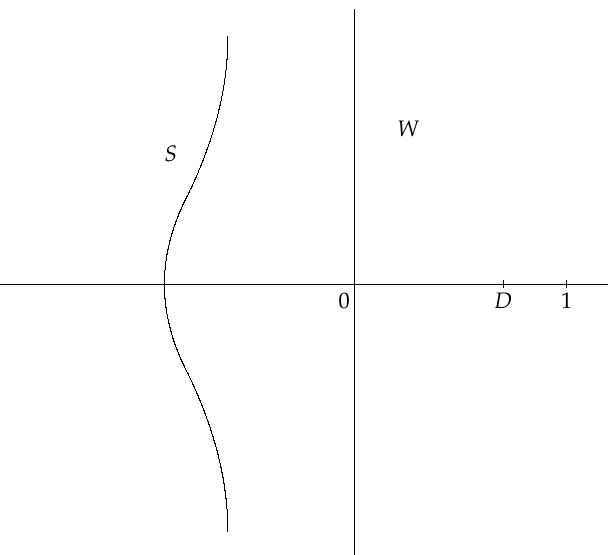
Figure 1. The screen S and the window W